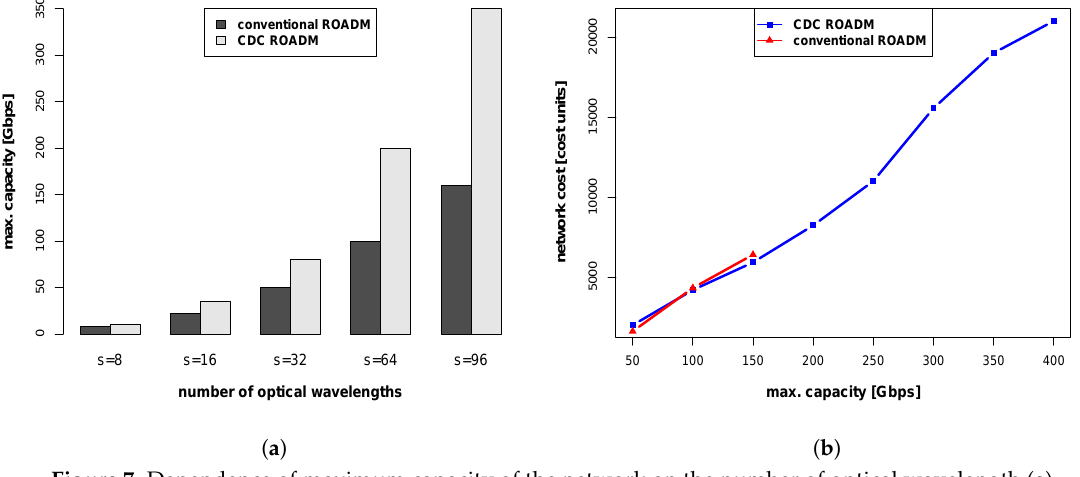
Figure 7. Dependence of maximum capacity of the network on the number of optical wavelength ( a ) and the dependence of network cost on maximum capacity of the network ( b ) for the US network. Table 4. Comparison of total network capacity for C-ROADM and CDC-ROADM, for tested